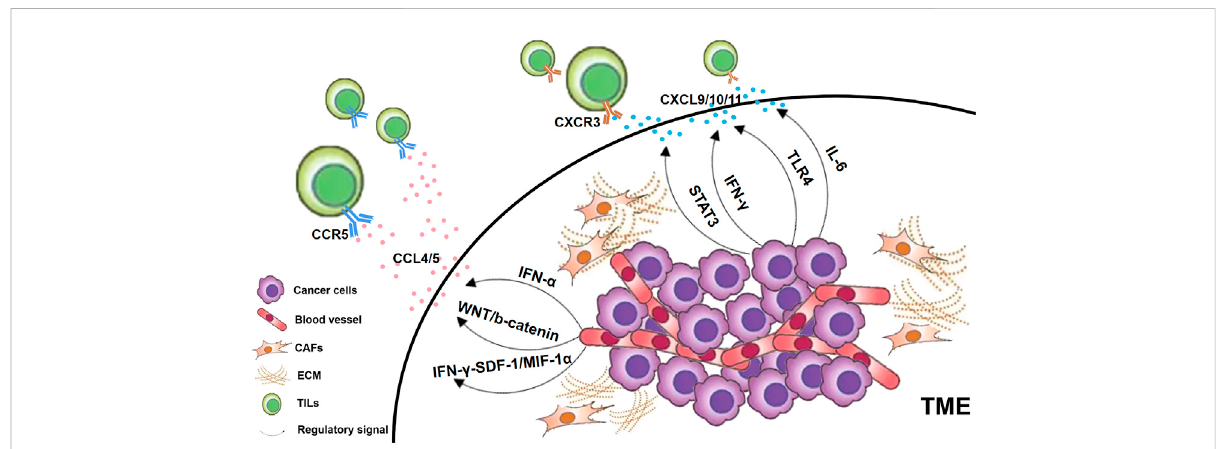
FIGURE 2 Chemokines regulated by in fl ammatory factors. In general, cancer cells in the TME, CAFs and ECM can all secrete chemokine ligands. Those T lymphocytes that express chemokine receptors on their cell surfaces are attracted to speci fi c chemokine ligands and thus home to the TME as TILs. CXCR3-CXCL9/10/11isakeychemokinereportedtobeassociatedwithTILsin fi ltration,whichisregulatedbyvarioussignalingpathwaysasshownin the fi gure. In addition, CCR5-CCL4/5 has also been found to be associated with the in fi ltration of TILs through multiple